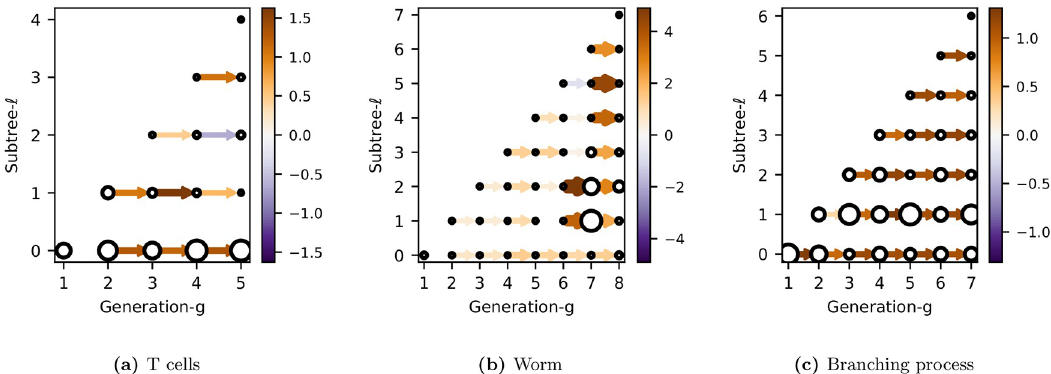
Fig 10. Dynamic lineage maps. These directed graphs in the natural variables show the dynamics of the bifurcated expression pattern in each subtree ℓ . The color (and thickness) of an edge between node j and j 0 corresponds to the transmission strength, β The size of the node corresponds to the innovation strength, E ð ε 2